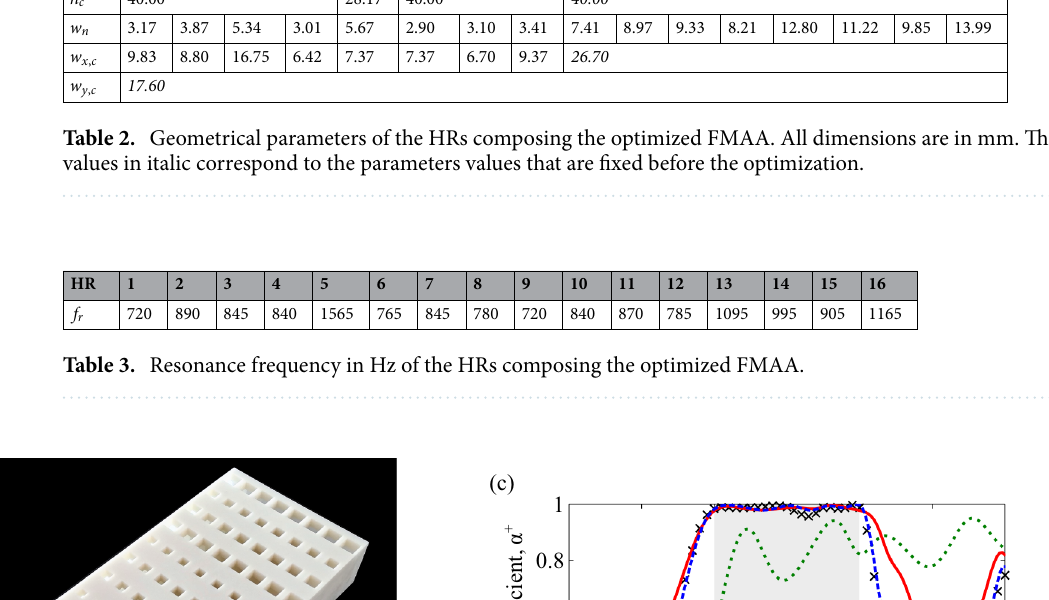
Figure 5. Optimized compact and broadband absorber for H tested sample. ( b ) Microscope picture of a HR neck. ( c ) Absorption coefficient, α + . ( d ) Transmission